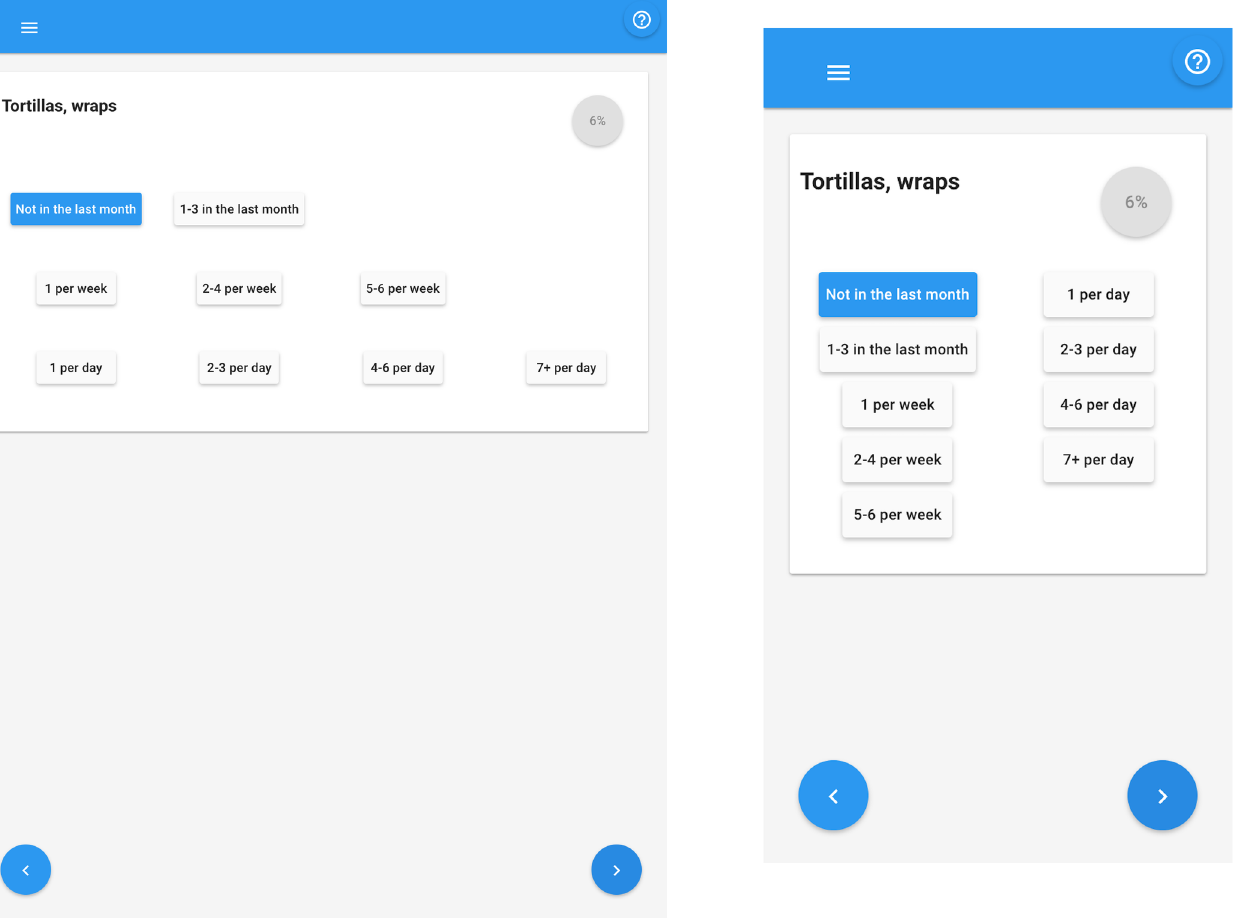
Fig 1. Food frequency options reordered and presented in medium and small screens.